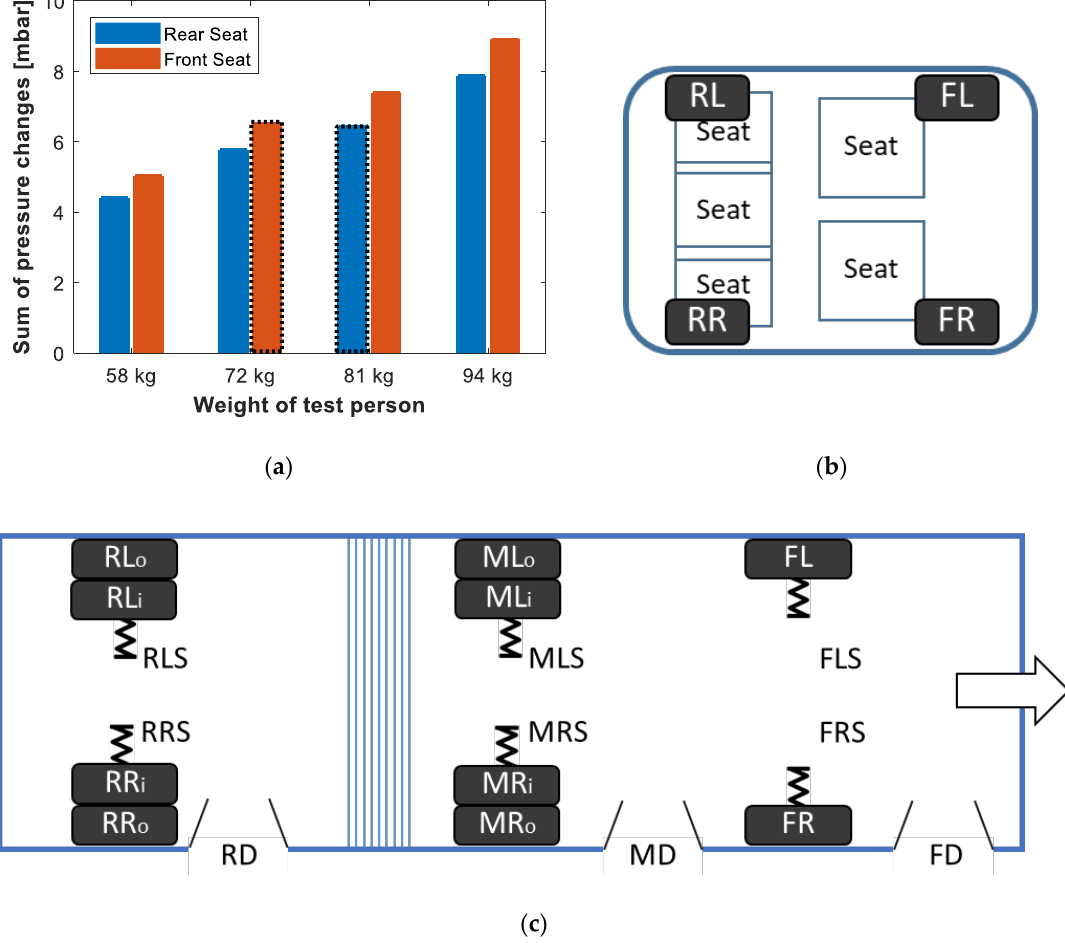
Figure 7. ( a ) Differences in total pressure change for front and rear seats, sum of all four tires (car). ( b ) Seat and tire positions (car). ( c ) Arrangement and numbering of tires, air springs and doors (bus). The rear seats are much closer to the rear tires, whereas the front seats are placed more centrally